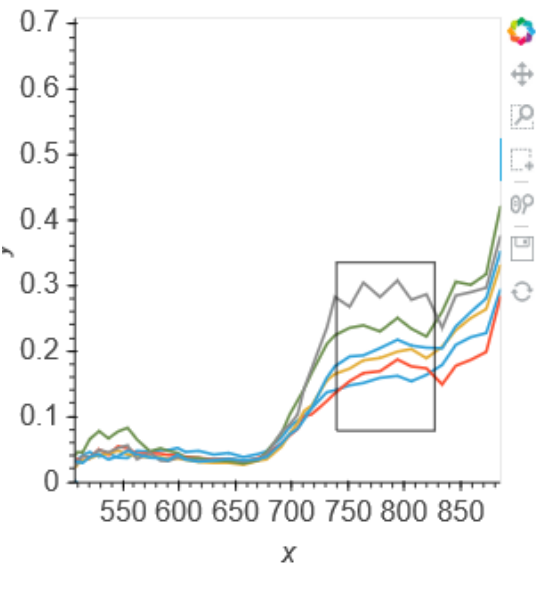
Figure 16. Screenshot of the spectre chooser.